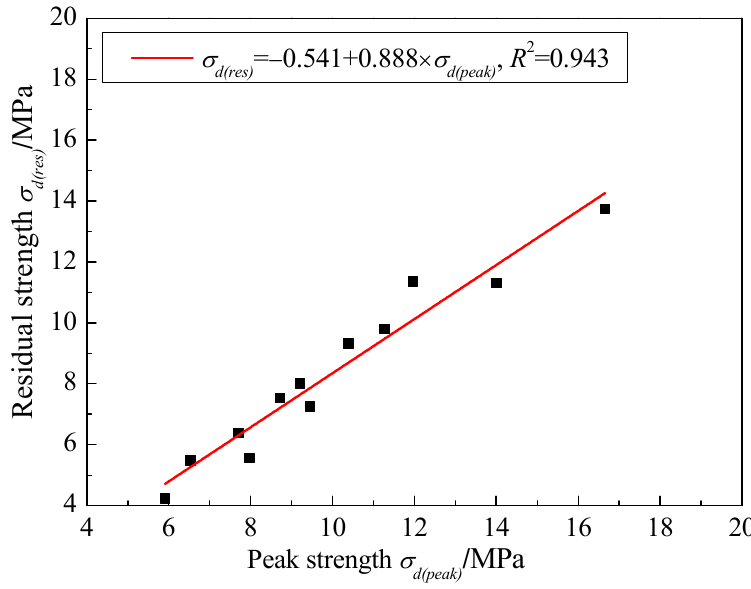
Figure 12. Residual deviator stress versus maximum deviator stress at various methane hydrate